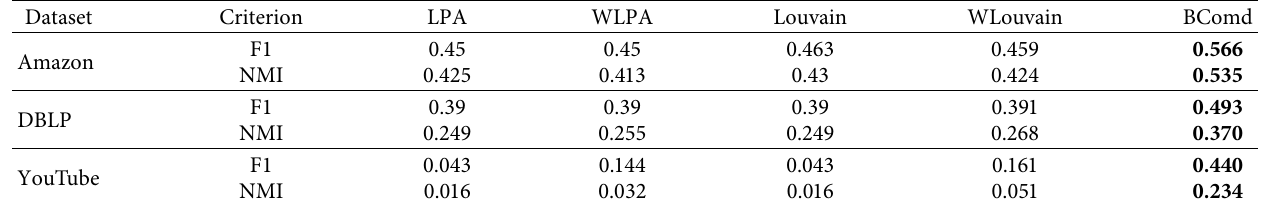
Table 3: Experimental results of the community-discovery algorithms on large graphs (F1 and NMI). Dataset